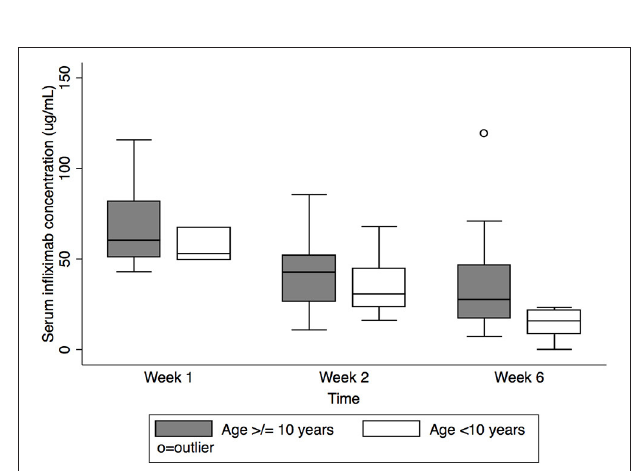
FIGURE 3 | Serum infliximab concentrations at week 1, pre-dose #2, and pre-dose #3 by age. Box plot values include: lower adjacent value, first quartile, median, third quartile, and upper adjacent value (in ascending order). Lower and upper adjacent values are the most extreme values within the first quartile minus 1.5 × interquartile range and the third quartile plus 1.5 × interquartile range,